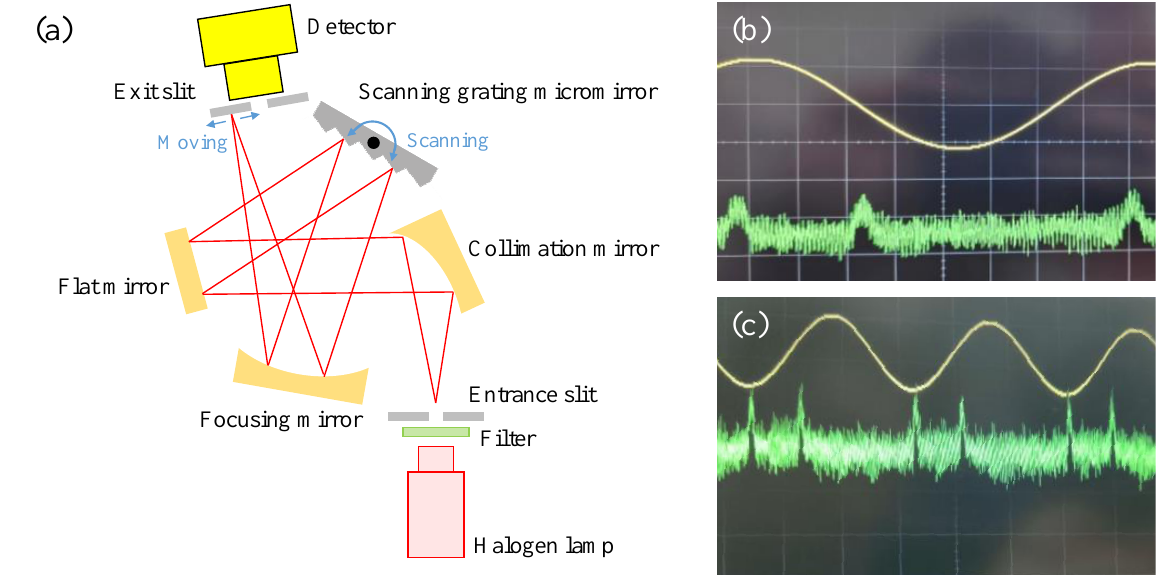
Figure 15. ( a ) Schematic diagram of diffracted wavelength range testing; ( b ) response of the photodetector to monochromatic light ( b ) 810 nm; ( c ) 2580 nm.